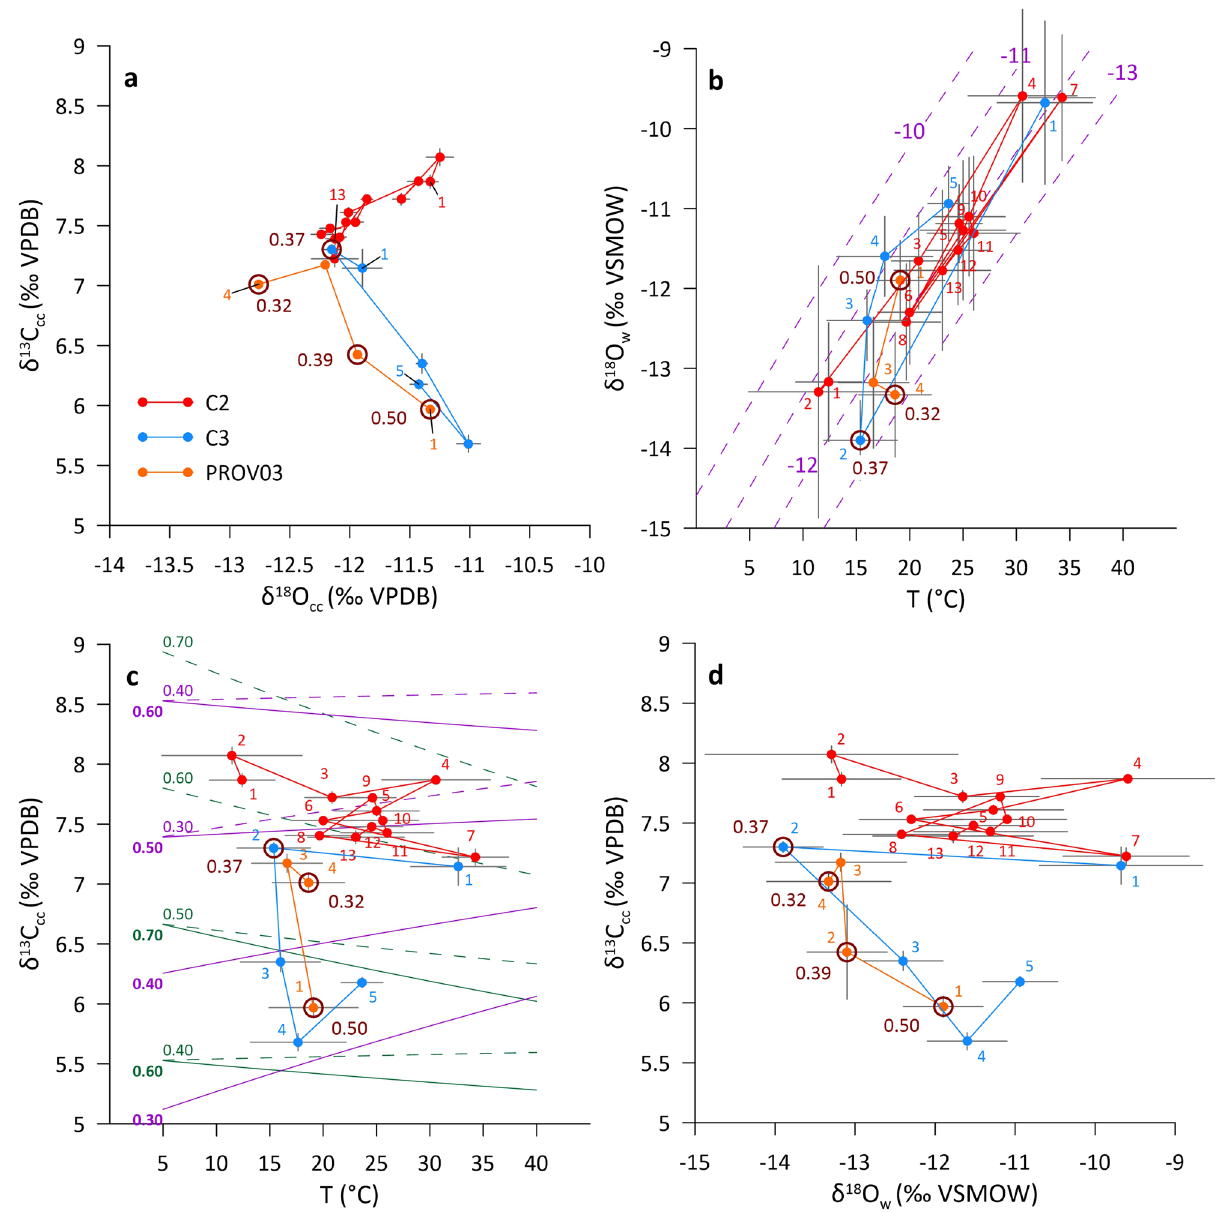
Figure 6. Stable isotope composition of calcite coatings from Provalata Cave. ( a ) Covariation of δ 18 O cc and δ 13 C cc values following generally two lines, one with positive, and one with negative slope. ( b ) Variation of δ 18 O w (from fluid inclusions or calculated) with temperature. Dashed purple lines show equilibrium lines for a given δ 18 O cc . ( c ) Variation of δ 13 C cc with temperature. Green and purple full lines show curves of modeled variation of δ 13 C cc with temperature change, with δ 13 C DIC at + 4‰ and + 1‰, respectively, for a selected f H 2 CO 3 (indicated for each curve) and 0.1 mol fraction of carbon in the degassed CO 2 (X c ). Closed system calcite precipitation (no degassing) is shown with dashed lines. See Supplementary Information for explanation of calculation and additional modeled curves. ( d ) Variation of δ 18 O w with δ 13 C cc . For each sample the stratigraphic sequence of stable isotope data is indicated to observe the trends in stable isotope change. Encircled symbols show noble gas fluid inclusion samples and associated values indicate R/R A values. See text for minor and relatively constant mantle He component. Variation in the δ 18 O w of the shallow component is very likely, and such increase in values can be due to climate variations (e.g., higher values in warmer and/or drier conditions and vice-versa 76 ). Although the effect of δ 18 O w change in the shallow component can be seen in the mixture δ 18 O w , the δ 13 C DIC change in the shallow component (carrying a soil δ 13 C signal, e.g., − 25 to − 10‰ 76 ) will be overprinted by the large fraction of deep-derived CO 2 (with endogenic δ 13 C signal, e.g., − 7‰ to − 4‰ for mantle, or > 0‰ for metamorphic CO 2 50,77 . If the deep-sourced CO 2 flux decreases, pCO 2 will decrease, leading to an increase in pH and lowering of the δ 13 C cc , but also relative increase in the shallow component carbon fraction,